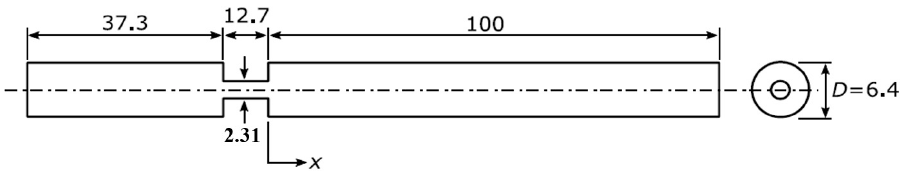
Figure 1. A sectional view of the flow domain. Flow is from left to right. The figure is out of scale, and the dimensions are in mm.